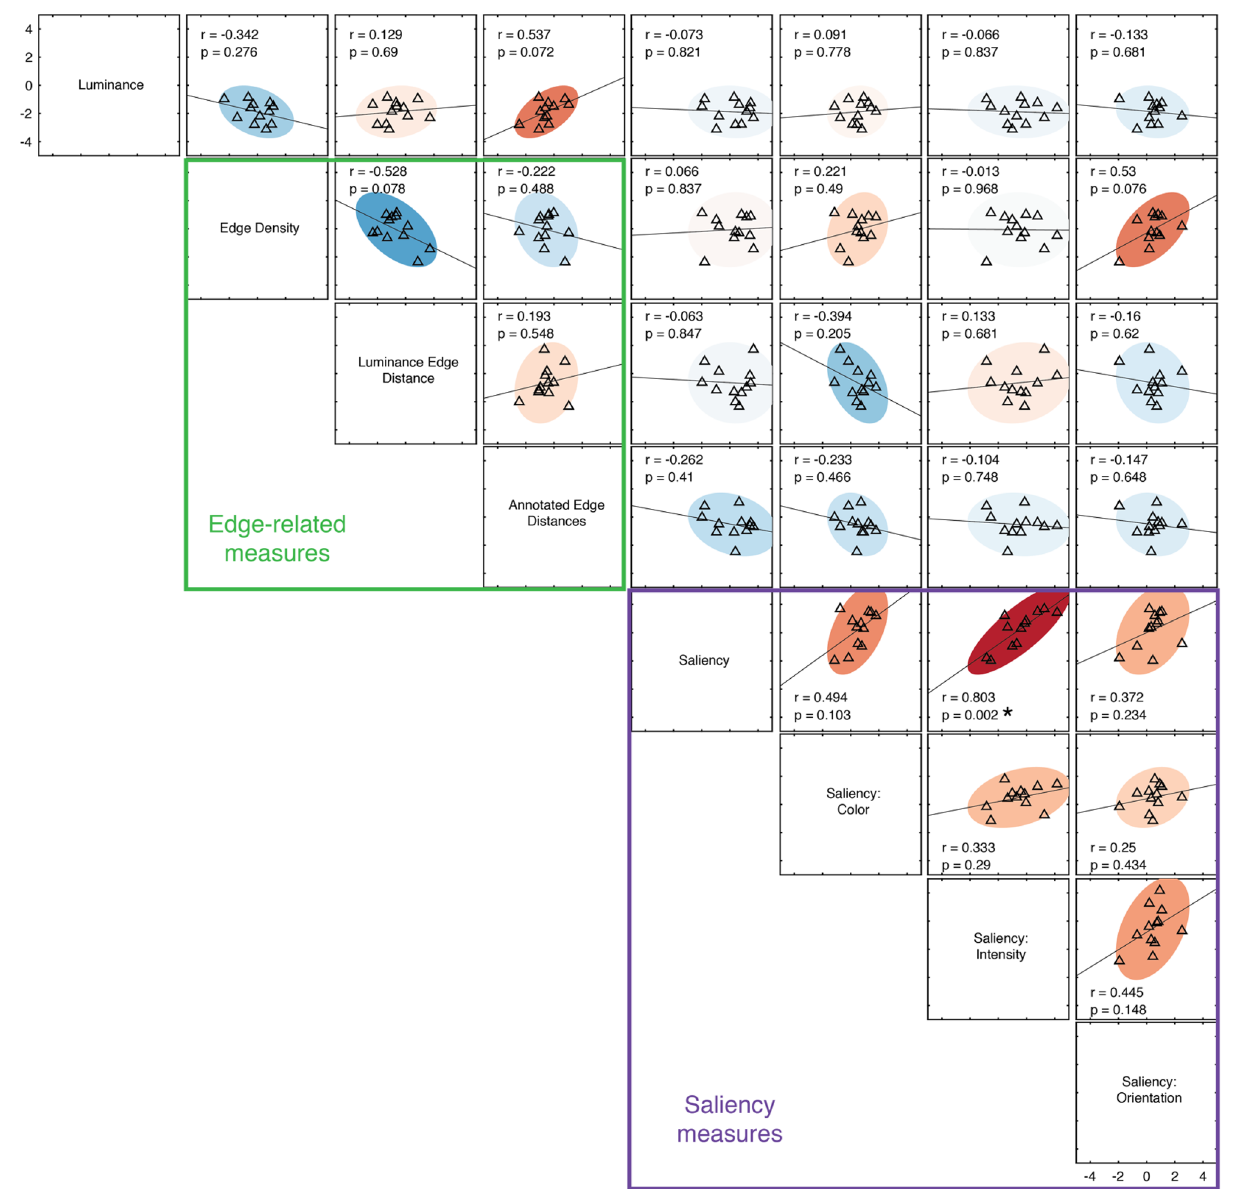
Figure 6. Between-participant correlations for all pairwise image features in Experiment 3 (N = 12). Each symbol represents the trial-averaged difference score (in z-units) for one participant. Filled oval regions represent 95% error ellipses, using the same color scale shown in Fig. 4. The asterisk (for the correlation between Saliency and Saliency: Intensity) indicates a statistically significant correlation after controlling for a false discovery rate of 0.05 using the Benjamini–Hochberg